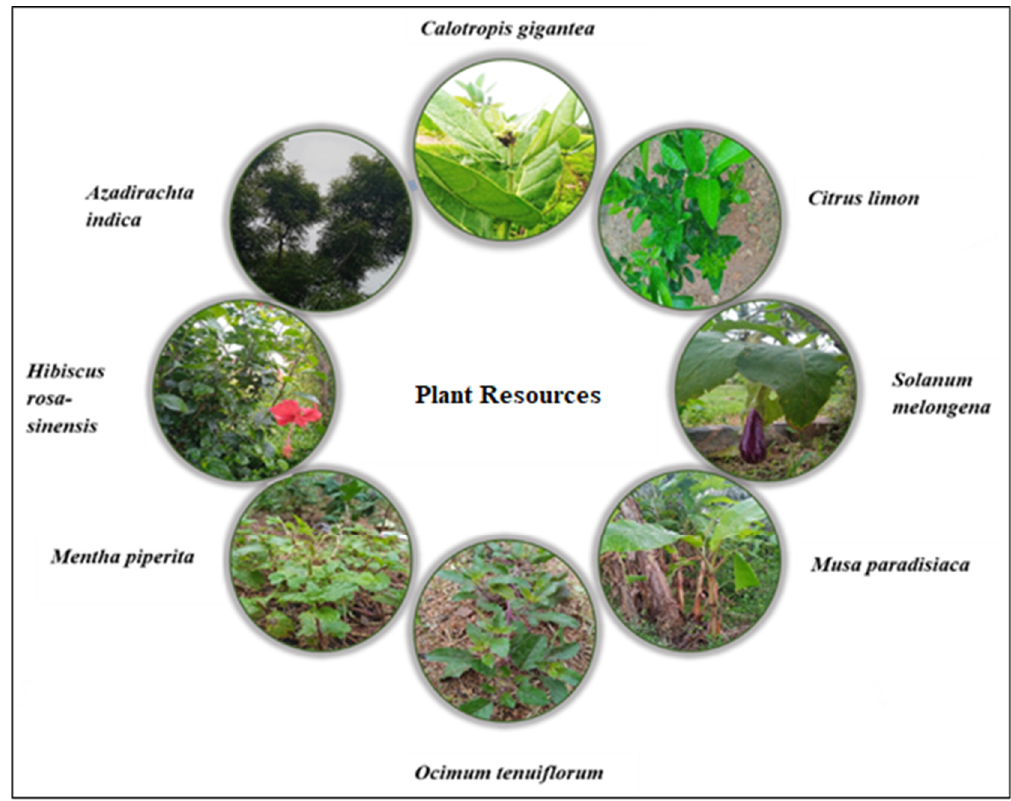
Fig. 3. Common plants used in the synthesis of inorganic